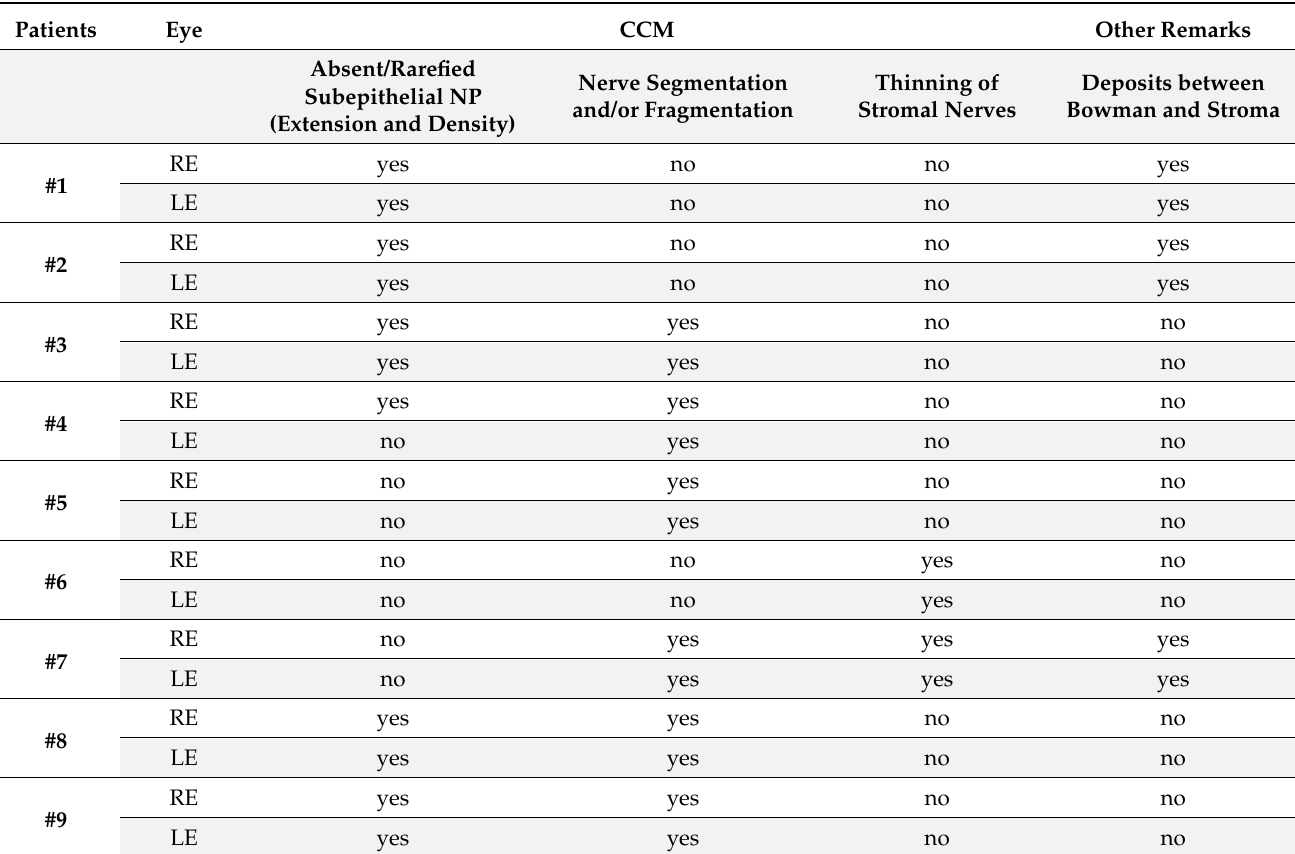
Table 3. Corneal